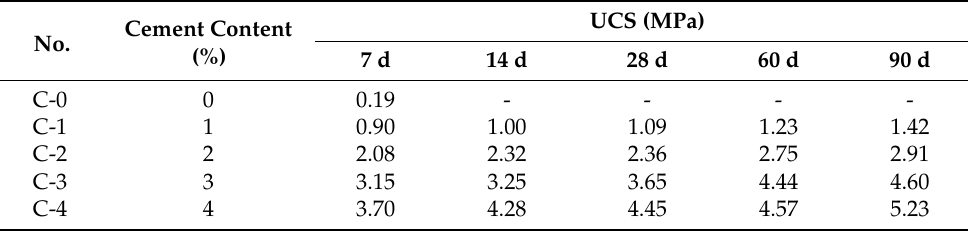
Table 2. Unconfined compressive strength test results.